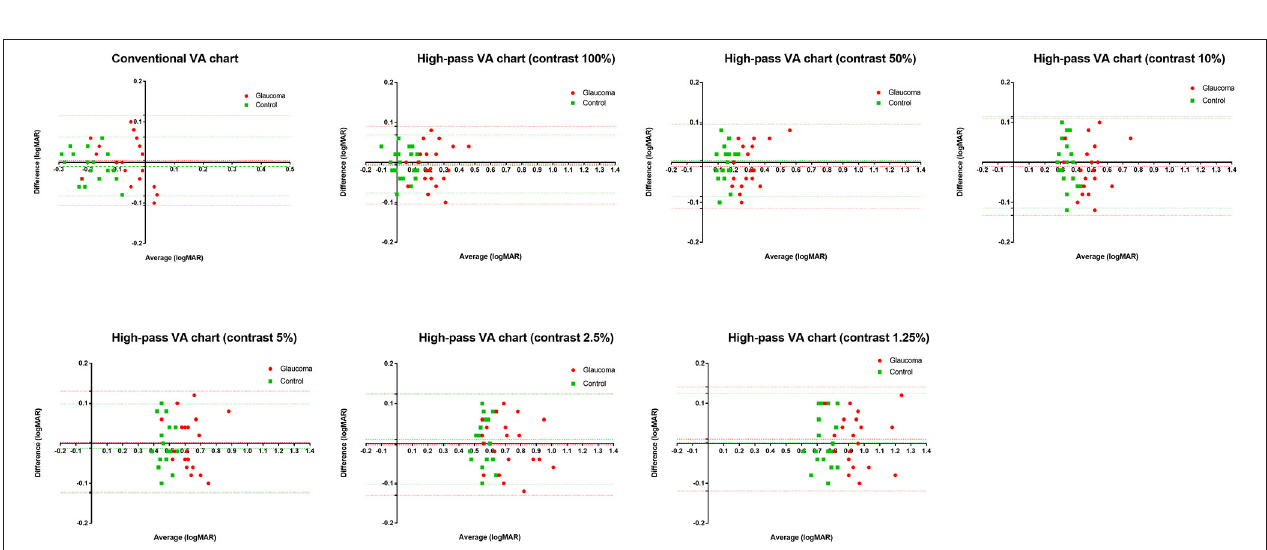
FIGURE 2 | OCT imaging in the current study: (A) the left image shows macular layers that were used for analyzing the structure-function relationships in this study. The right panel shows the overlay of the GCL thickness heat map on a fundus image. The inner and outer annuli were divided into four quadrants (IS, IT, II, IN and OS, OT, OI, ON) according to the ETDRS map. (B) the upper image shows the cpRNFL scan. The lower picture shows the sectoral cpRNFL thicknesses classification, specifically the global average of the circle scan (G) and N, NS, TS, T, TI, and NI quadrants.